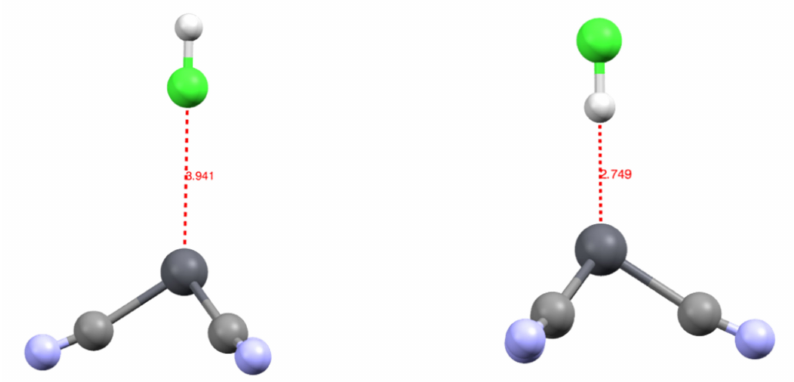
Figure 3. Structure of the [Pb(CN) 3 (ClH)] − ( left ) and [Pb(CN) 3 (HCl)] − ( right ) complexes with distances in